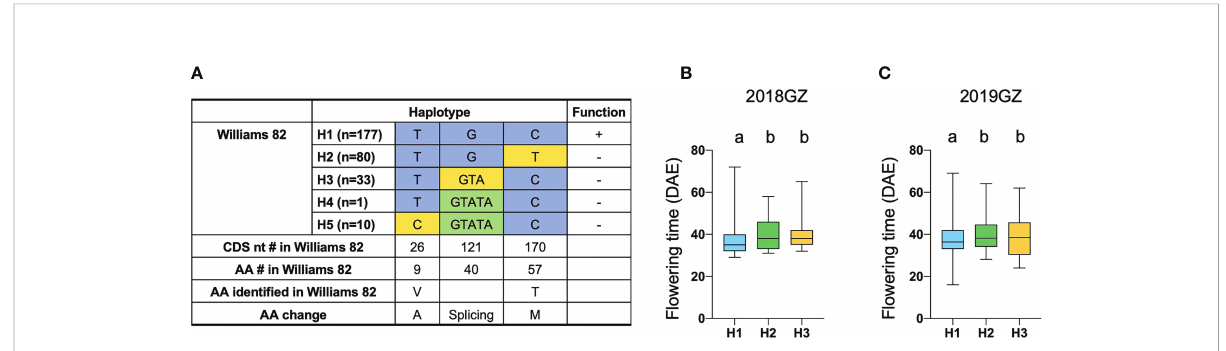
FIGURE 6 Flowering time variations of different alleles in LJ18. (A) Haplotypes and their origins of LJ18. (B, C) Variation of fl owering time of LJ18 haplotypes from the 338-accession panel. 18GZ, the accessions were planted in Guangzhou, China, in 2018; 19GZ, planted in Guangzhou, China, 2019. Two-tailed, two-sample t-tests were used to generate the P values. Data represent mean ± SD of three biological replicates. Different lowercase letters represent signi fi cant differences at the level of P < 0.05, based on the Student ’ s t